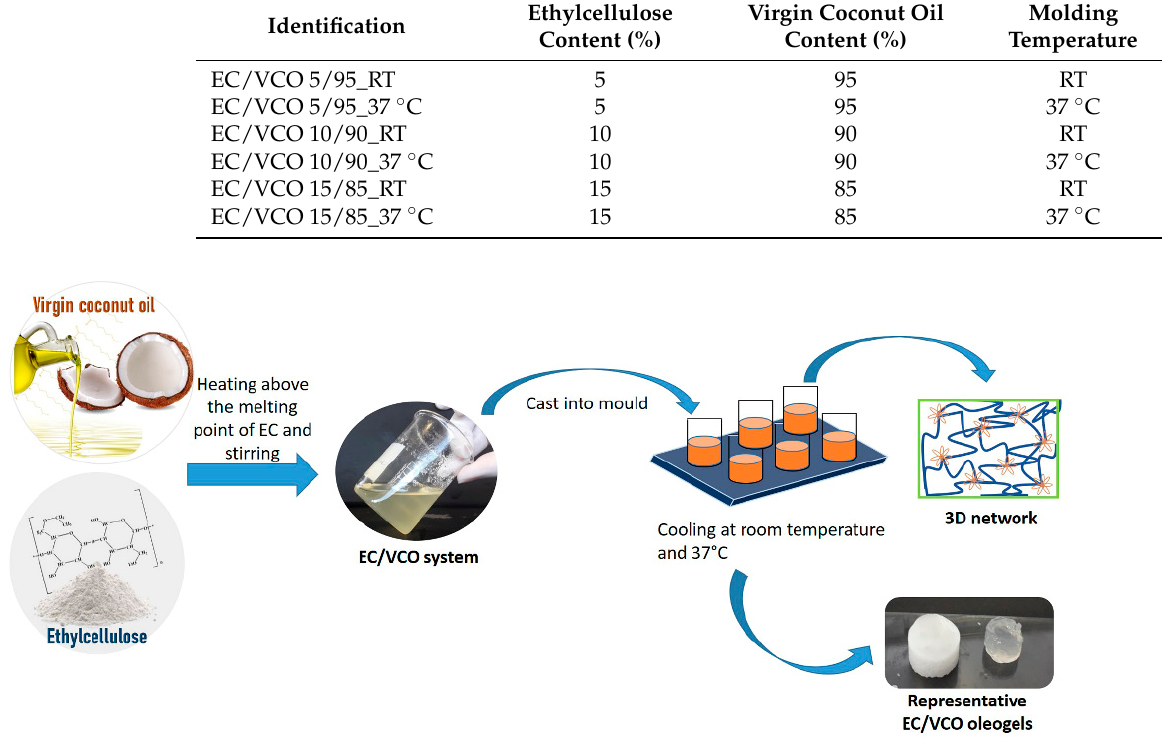
Virgin Coconut Oil Content (%)